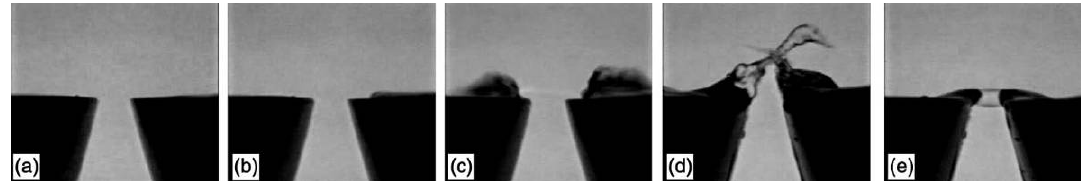
Figure 6. Formation of a water bridge between two Teflon beakers. (a) No current applied, (b) rise of the water surface mainly in the anodic beaker at approximately 15 kV dc, (c) spark, (d) water jet ejection leading to (e) a stable connection between the beakers (left cathode, right anode beaker) (from [89]).